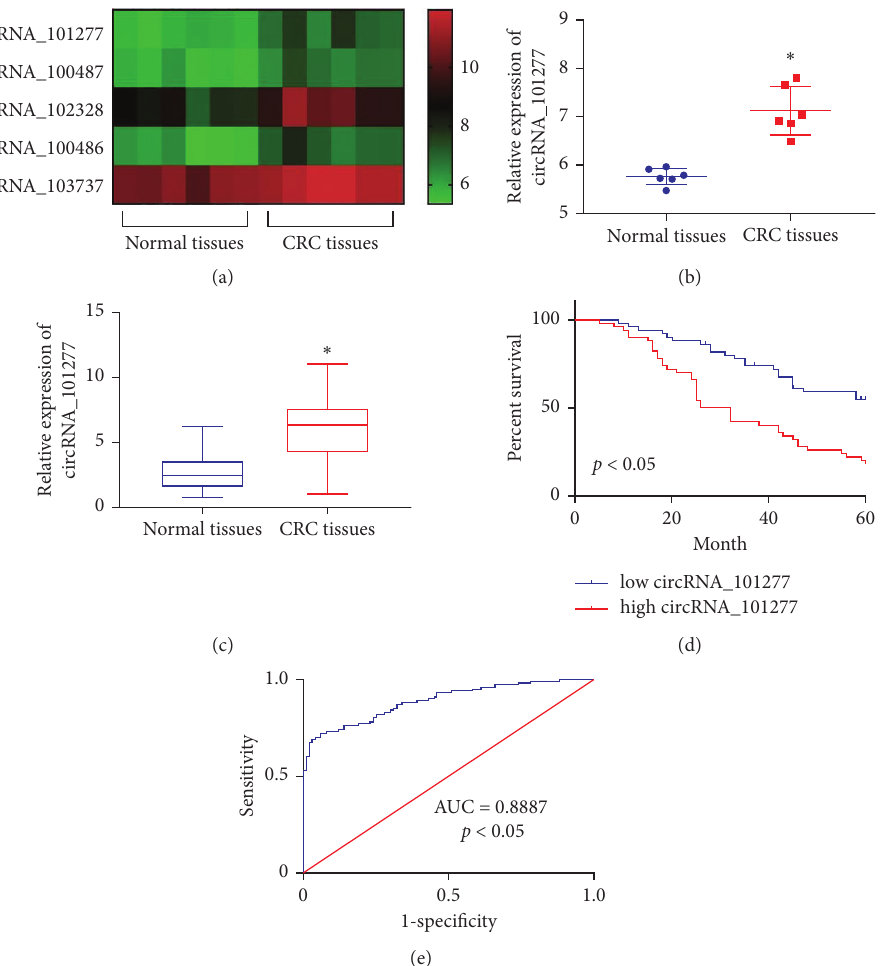
Figure 1: CRC is associated with circRNA_101277 upregulation. (a) Hierarchical clustering analyses were used to detect differences in circRNA expression profiles between CRC and healthy tissues. (b) Relative circRNA_101277 levels were measured in normal tissues and CRC tissues. (c) circRNA_101277 levels in 100 pairs of CRC and healthy tissues were assessed via qRT-PCR. (d) The overall survival of CRC patients with high circRNA_101277 expression was significantly worse than that of patients with low expression of this circRNA. (e) ROC curve analyses revealed that circRNA_101277 was able to effectively discriminate between tumor and adjacent tissues. ∗ p < 0.05. Table 1: Correlations between clinicopathological features and circRNA_101277 expression in 100 CRC tissue samples. Clinicopathological features